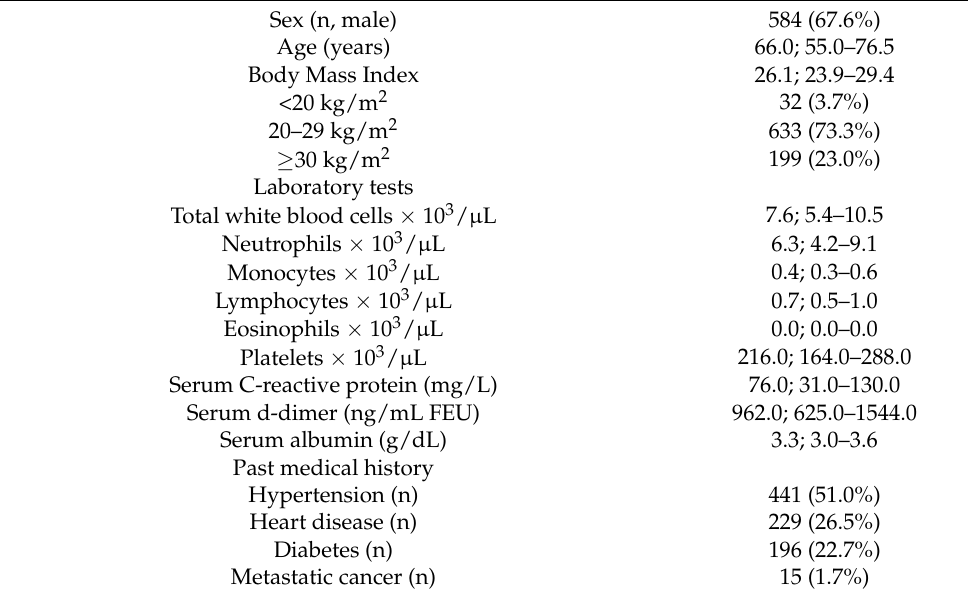
Table 1. Main characteristics of the study population at hospital